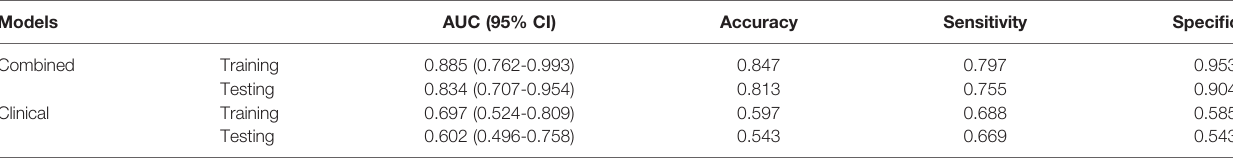
TABLE 5 | ROC curve analysis of the clinical model and the combined model with support vector machine in the training and testing cohorts. Models